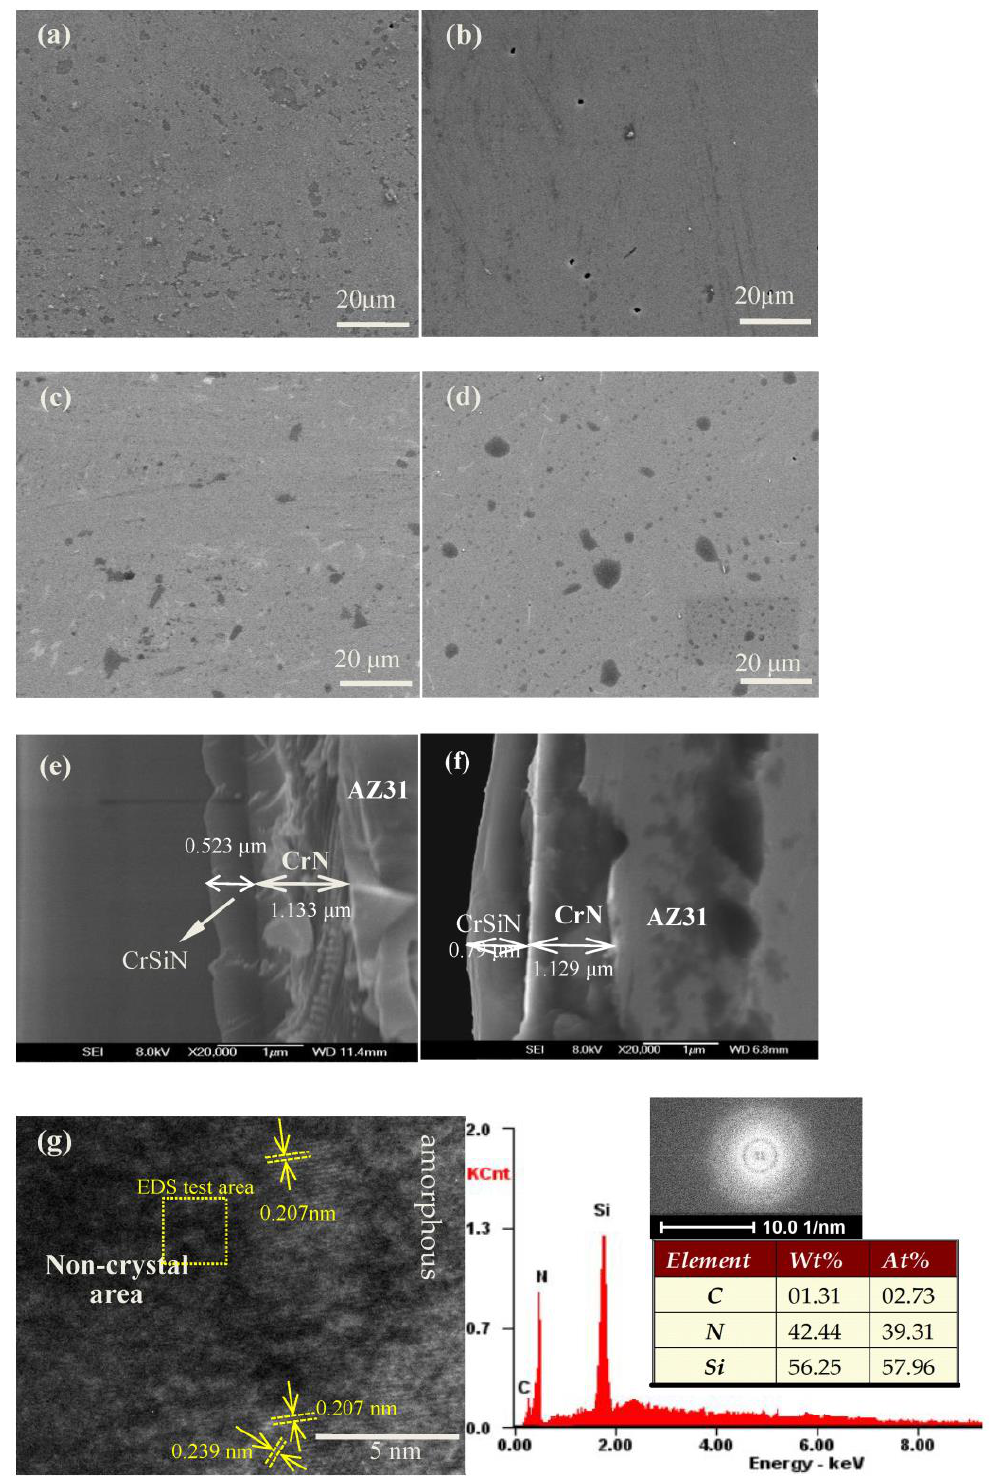
Figure 2. Morphology observation of the composite coatings ( a ) 20 min; ( b ) 35 min; ( c ) 50 min; ( d ) 65 min; ( e , f ) cross-section of 35 min and 50 min; ( g ) HRTEM of 50 min.